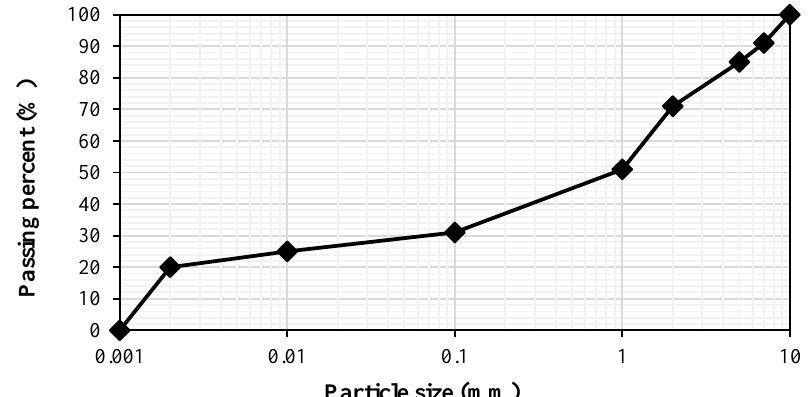
Fig. 1. Gradation curve of the soil used in this research